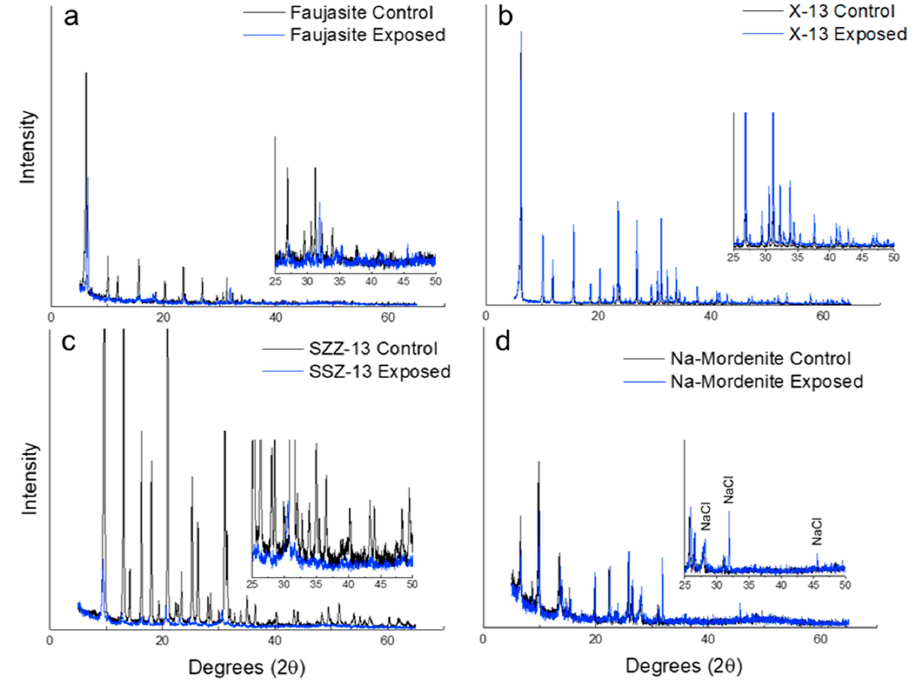
Figure 1. Diffraction patterns of ( a ) faujasite (FAU) (cage size ~2–13 Å), ( b ) faujasite (X-13) (cage size ~13 Å), ( c ) chabazite (SSZ-13), and ( d ) sodium-stabilized mordenite (Na-Mordenite).